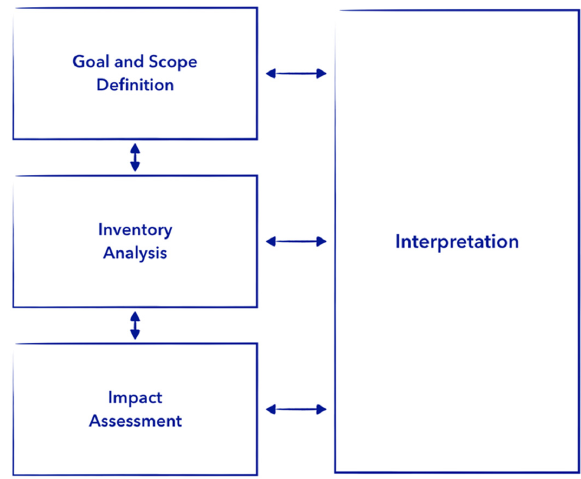
Figure 1. Phases of an LCA according to ISO 14040:2006 [1].